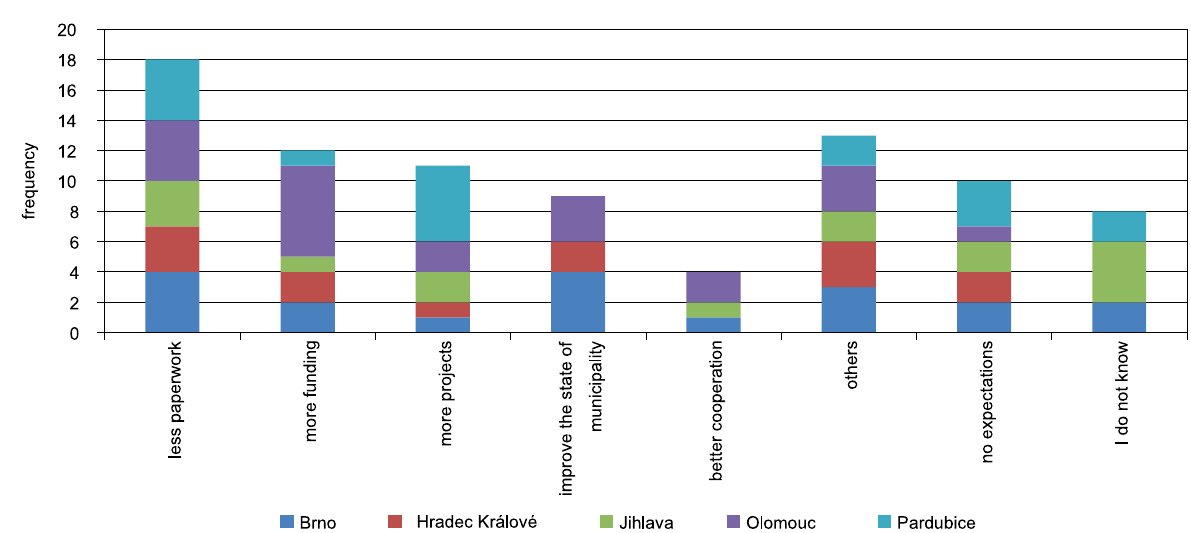
Fig. 3. Expectations of municipalities in the hinterland associated with the 2014–2020 programming period. Source: Survey of 69 municipalities in the hinterland of the selected core cities, GaREP, 2014